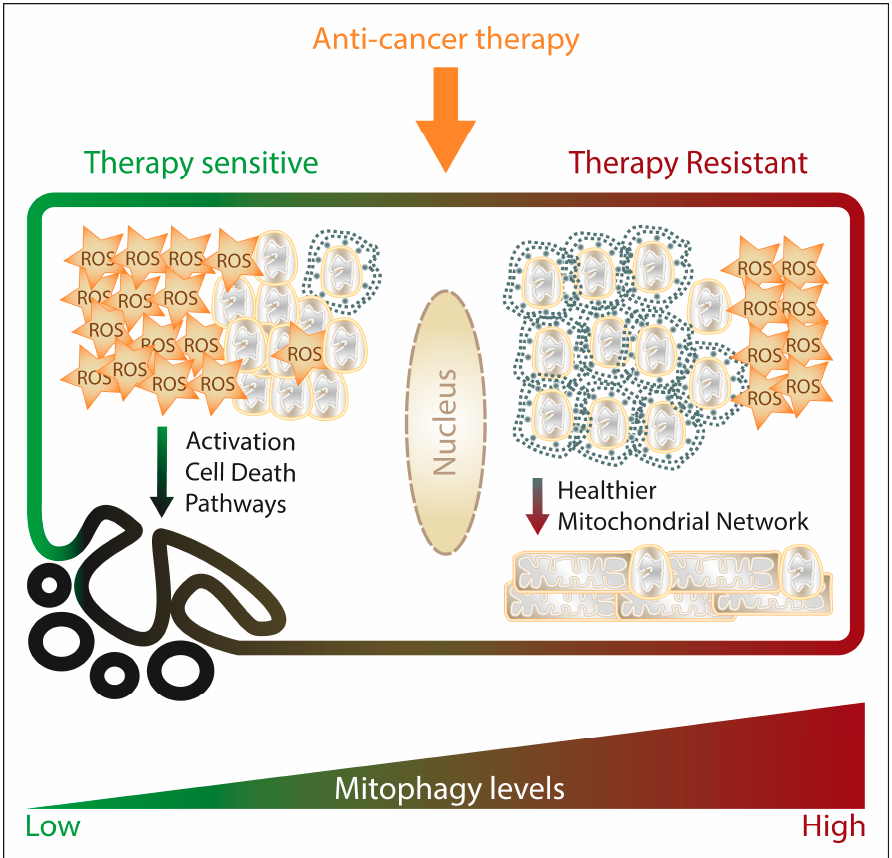
Figure 3. The figure schematically summarizes how mitophagy would modulate the response and resistance of cancer cells to anticancer therapies impinging on mitochondrial functions. Upon anti-cancer treatment, cancer cell mitochondria depolarize and start producing ROS, which if accumulating to lethal levels, trigger apoptosis as major cell death pathway. High mitophagy levels within the treated cancer cell contribute to withstand the damage caused by the treatment and counteract the onset of cell death programs, by maintaining a healthier mitochondrial network (limiting ROS production and accumulation of depolarized mitochondria, preventing cytochrome C